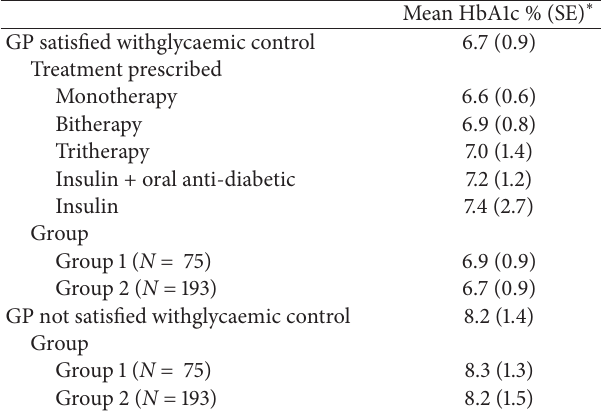
Table 2: Association of HbA1c values with GP satisfaction of glycaemic control and with treatment types among all included patients ( N = 268).